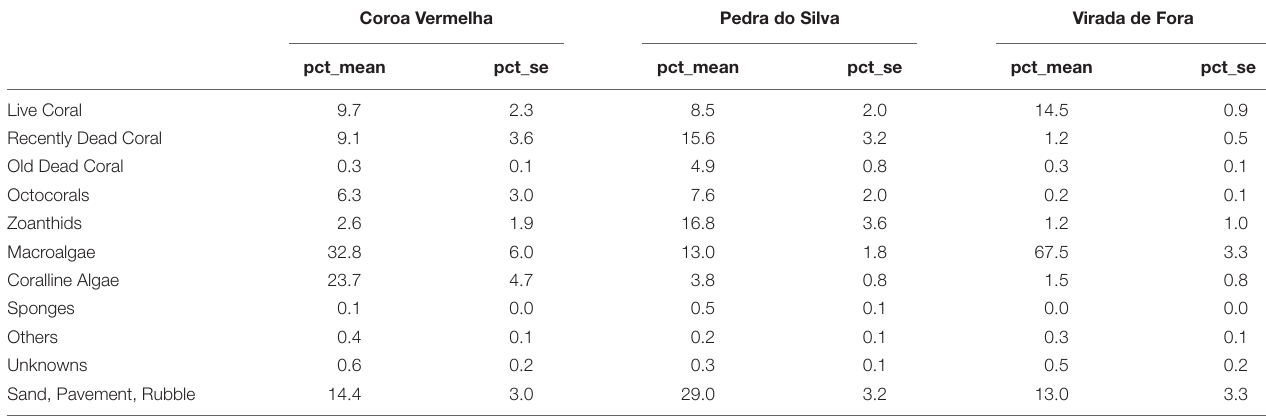
TABLE 3 | Benthic cover by major groups and total coral mortality rates in Coroa Vermelha, Pedra do Silva, and Virada de Fora reefs (se = standard error). Coroa